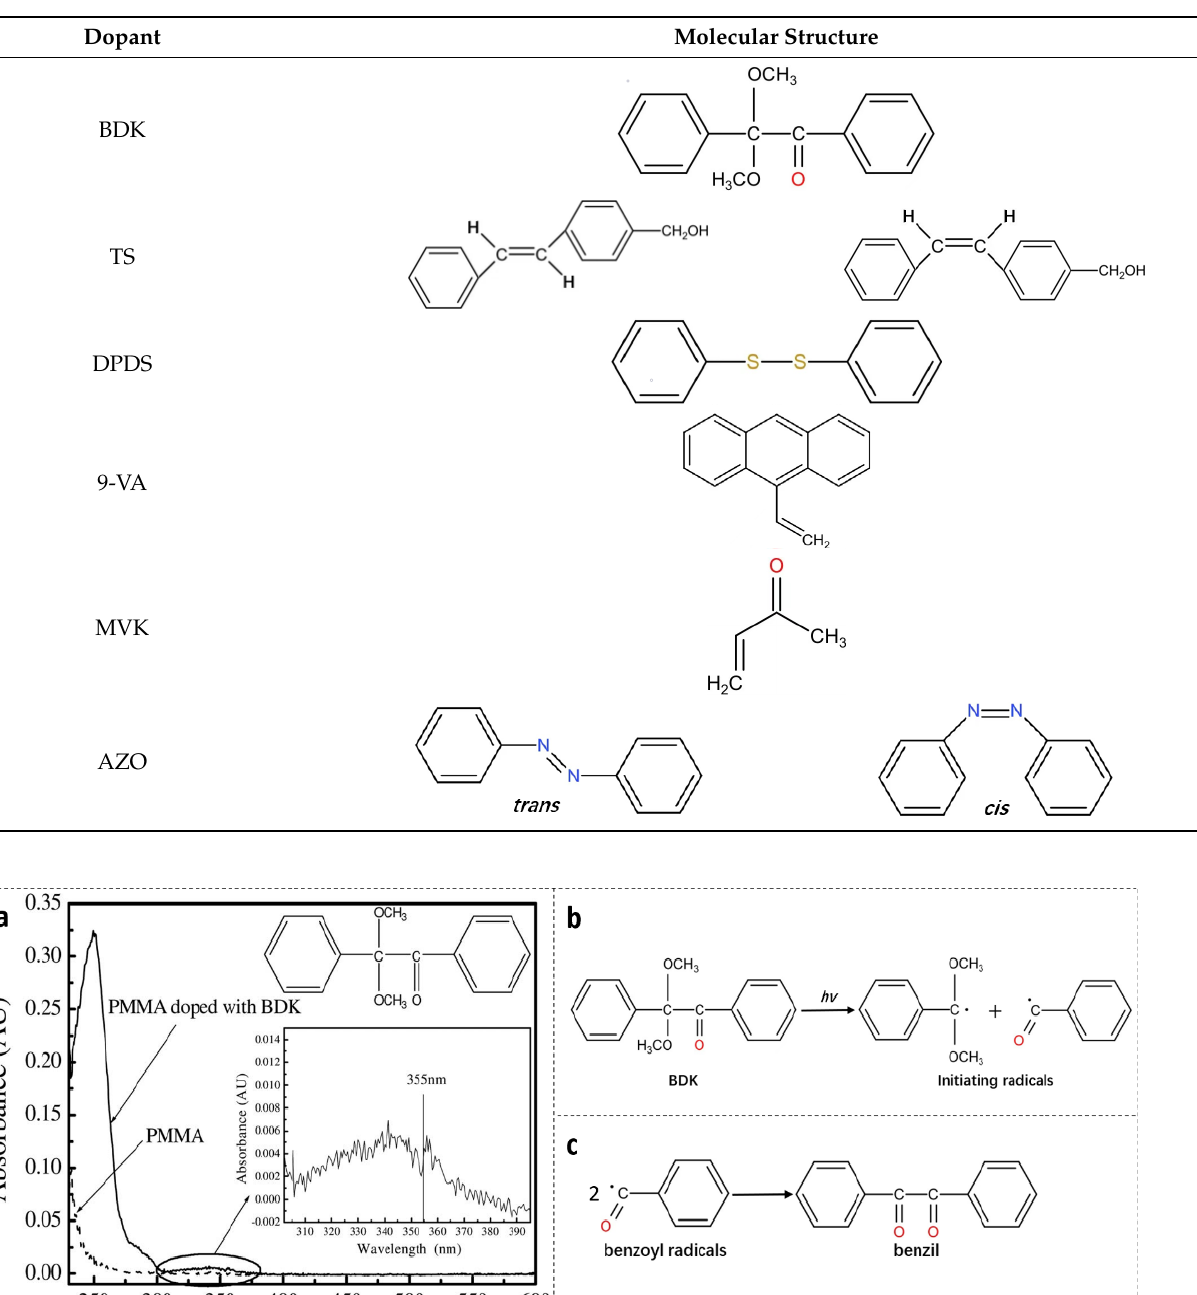
Figure 1. ( a ) Absorption spectra of PMMA and BDK-doped PMMA, the inset shows the zoomed-in absorption spectrum from 302 to 395 nm. Reprinted with permission from [19]. ( b ) Structure change of BDK under UV irradiation [20,21]; ( c ) Formation of benzil molecules from benzoyl radicals gen- erated under UV irradiation on BDK [20,21].